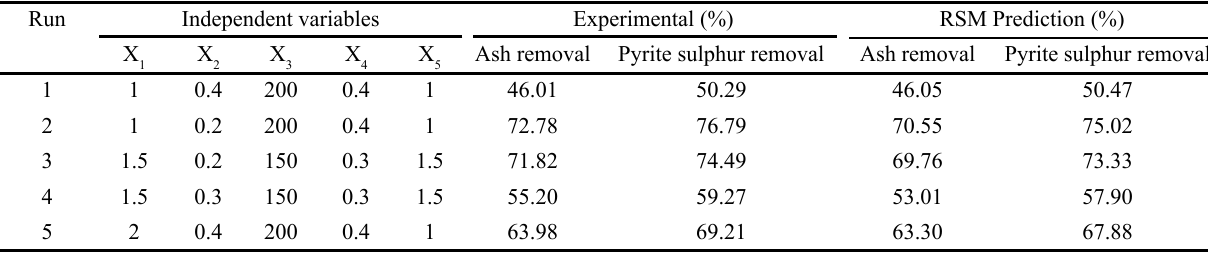
The predictability of the optimized models using five independent experimental runs. Run Independent